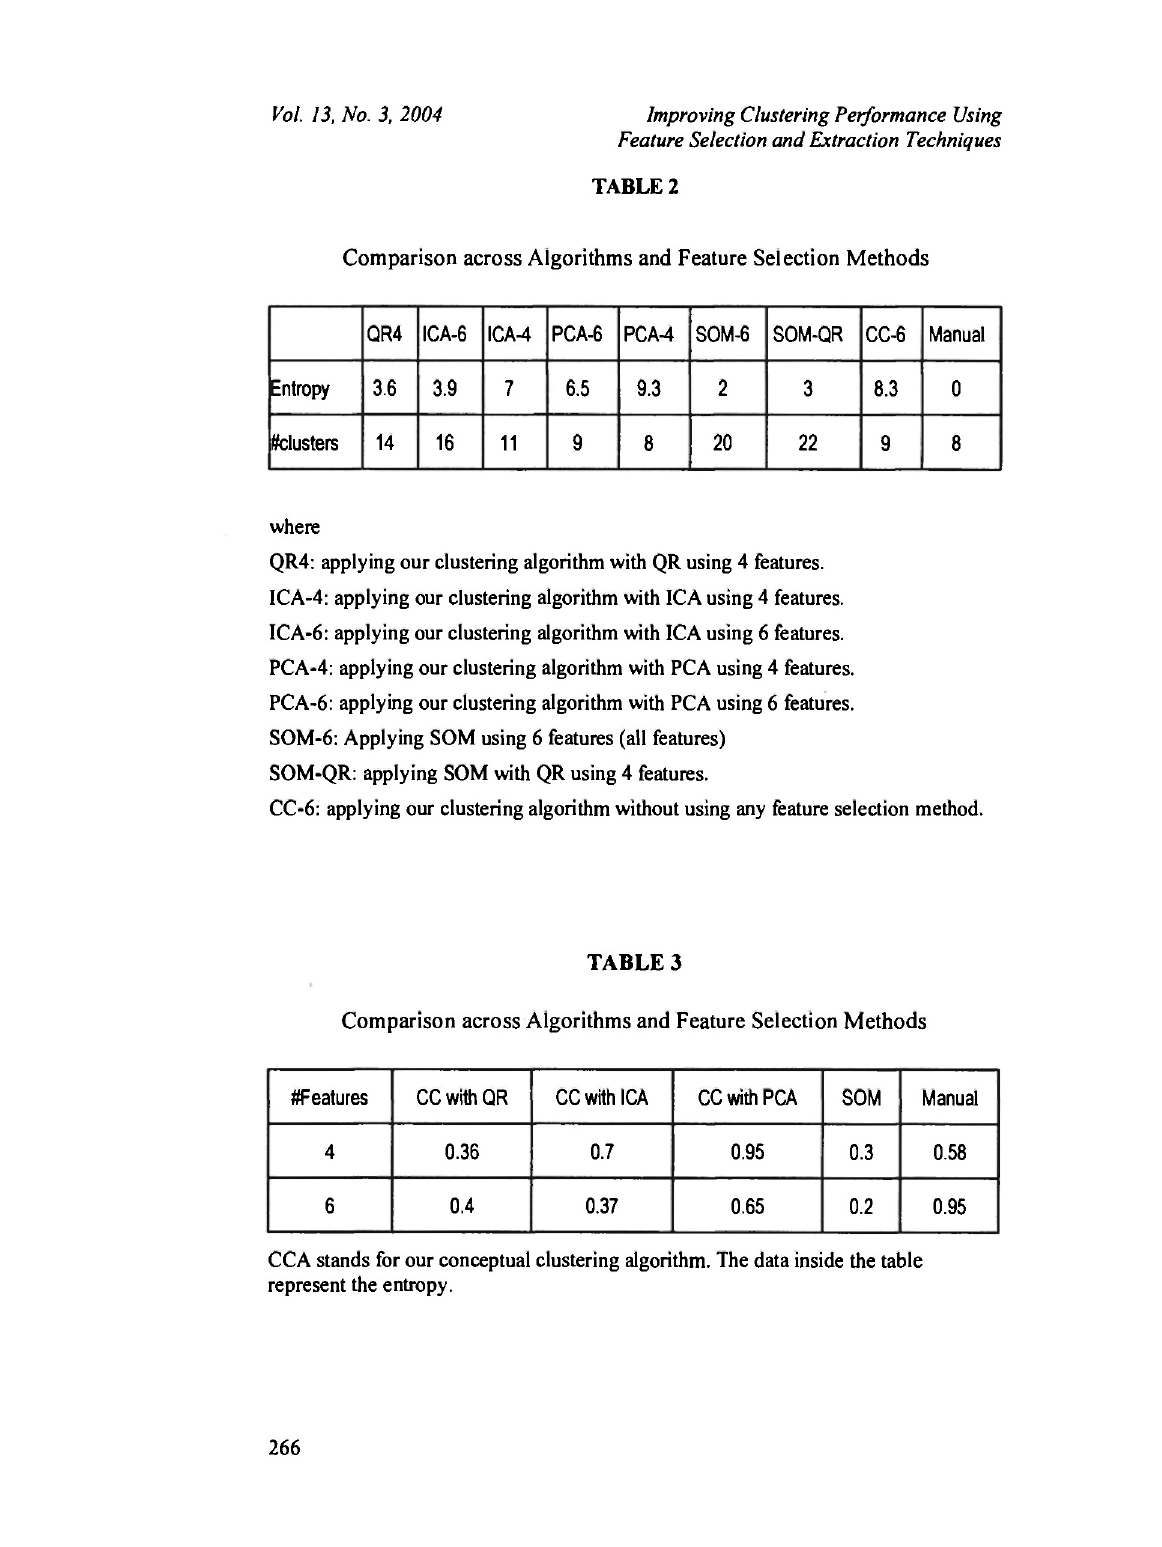
Comparison across Algorithms and Feature Selection